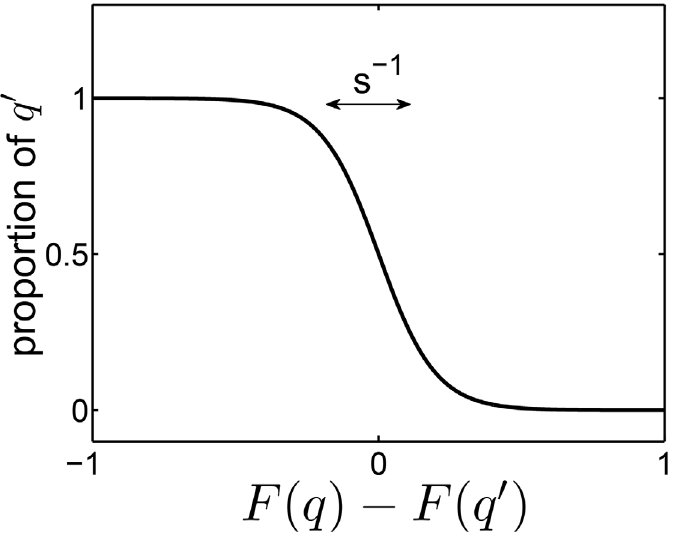
Fig 2. Selection imposes a characteristic length-scale along the q -axis. If a patch is seeded by two individuals with trait values q and q 0 , then, by the end of the selection stage, the fraction of q -individuals in the patch is given by C 2 ( q 0 ; q ) = [ e s ( F ( q ) − F ( q 0 )) +1] − 1 , which is a sigmoidal curve with a characteristic length * 1/ s